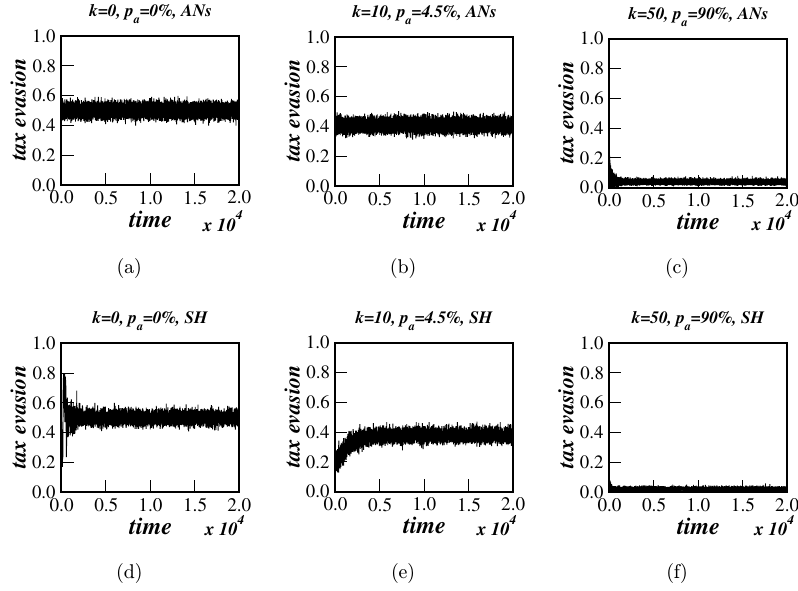
Fig. 4. The same simulation design as in Fig. 2, but now on ANs and SHP.